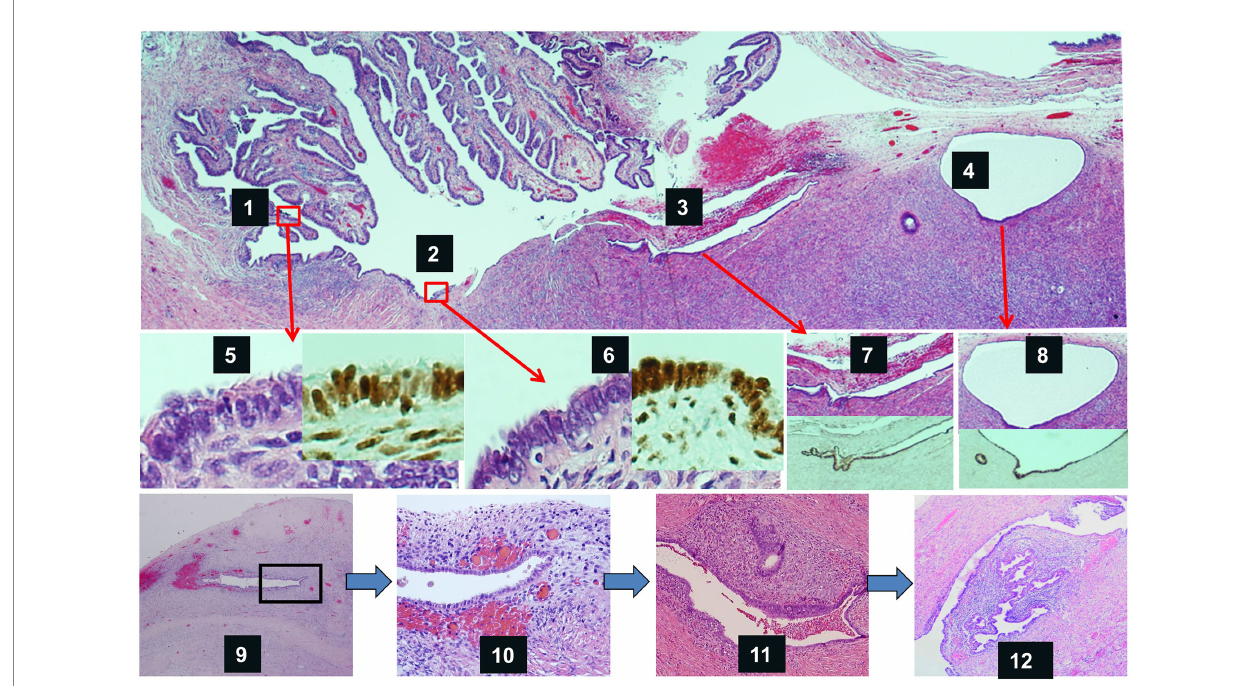
FIGURE 5 Graphic abstract of the process of ovarian endometriosis developed from tubal epithelia. Top panel shows tubal fimbriated end adherent to the ovary. Tubal epithelia (1) spreads to the ovarian surface (2), invaginates onto ovary through adhesions (3), and forms endosalpingiosis or ovarian epithelial inclusions (4). Mid-panel shows magnified morphology as well as Pax-8 IHC stains of tubal epithelia (5), epithelia on the ovarian surface (6), epithelia within ovarian surface adhesions (7), and endosalpingiosis (8). Low-panel shows endometriosis develops from initial endometriosis within the ovary. Endosalpingiosis like gland start to have endometrioid stroma and increased micro capillary vessels (9), more apparent in a magnified view (10), endometriosis without evidence of bleeding (11), and typical appearance of endometriosis in the ovary